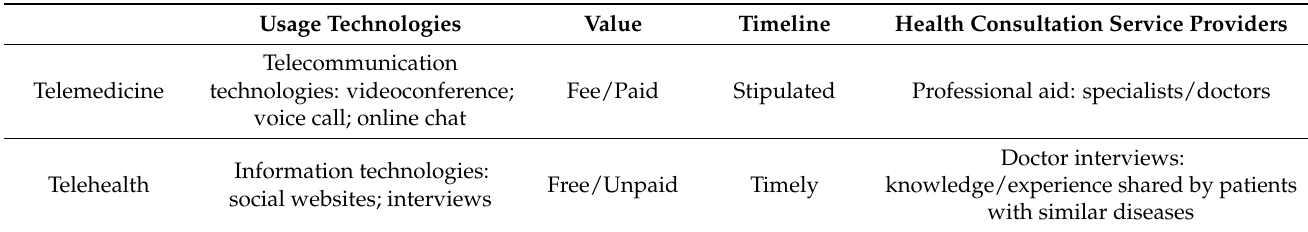
Table 1. Differences between telehealth and